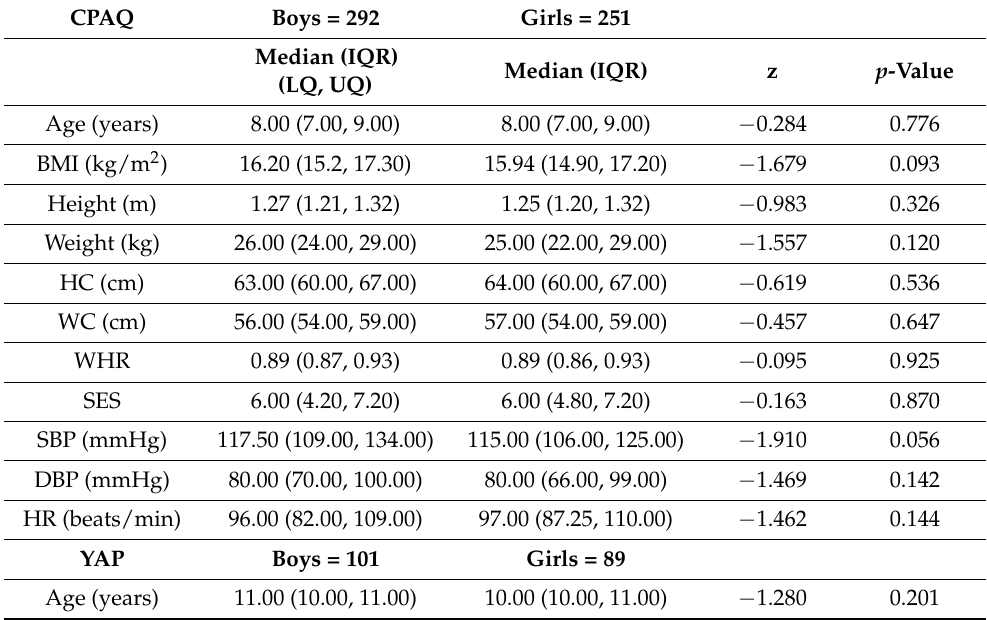
Table 1. Comparison of participants’ socio-demographic, anthropometric and cardiovascular vari- ables across